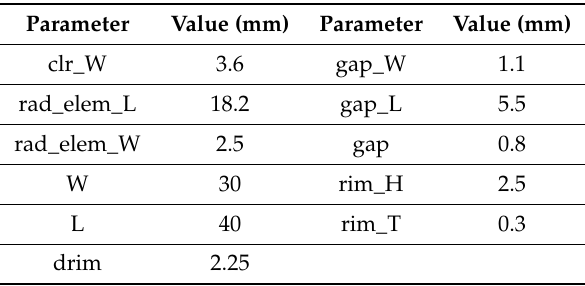
Figure 1. The structure of proposed antenna in ( a ) isometric view and ( b ) top view. Table 1. Antenna